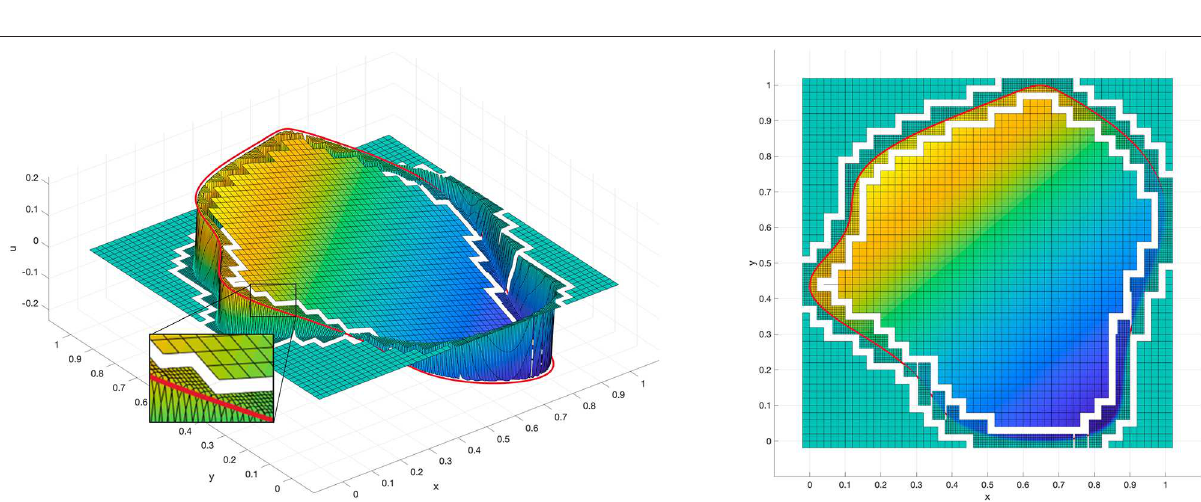
Frontiers in Mechanical Engineering |